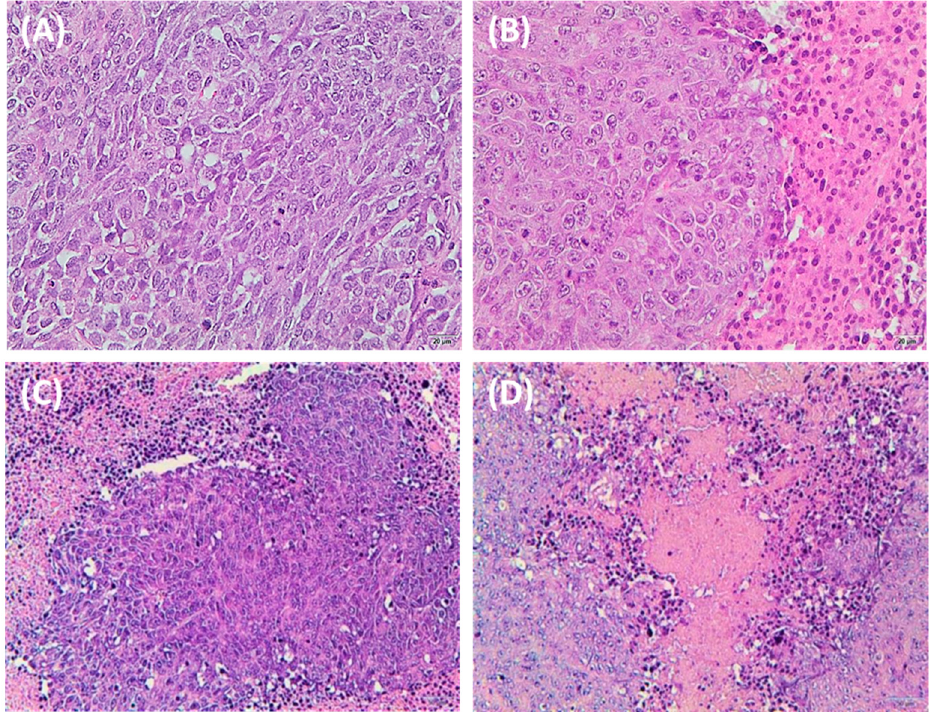
Figure 7. Histochemical staining of HCT-116 tumors from mice at 28 days after treatment compris- ing control ( A ), SN-38 micelles ( B ), Sunitinib micelles ( C ), and SN-38/Sunitinib micelles ( D ). The main tissues and HCT-116 tumor of mice sections were analyzed using hematoxylin and eosin (H&E, 200× magnification).